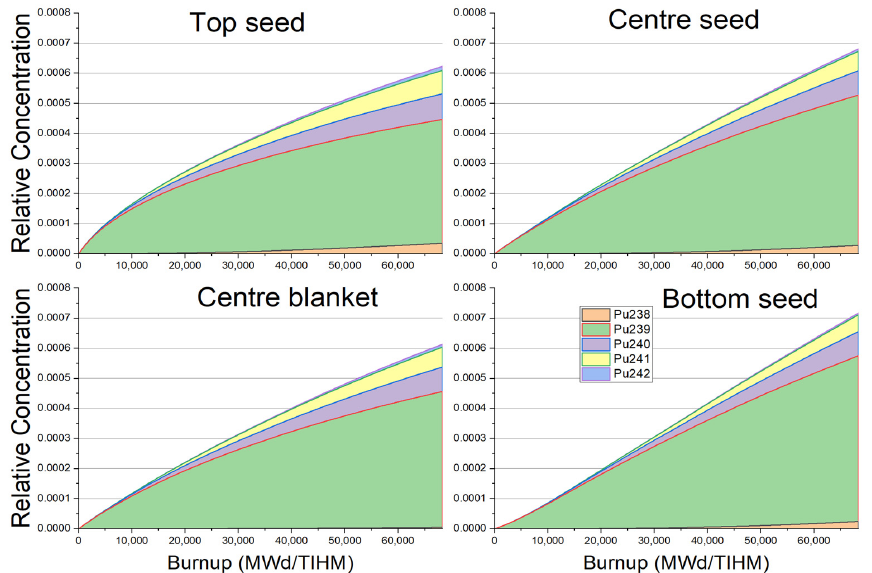
Figure 11. Concentrations of different plutonium isotopes throughout a burnup cycle, for a seed and blanket structured pin with regions of 20 cm size. The production of fissile plutonium (Pu-239 and Pu-241) in the top seed is faster at the start of the burnup cycle, in the region where the water density is lowest. The opposite is true for the bottom of the reactor pin. The central blanket region produces less plutonium than any seed region, but still yields over 70% of the plutonium of the central seed region.